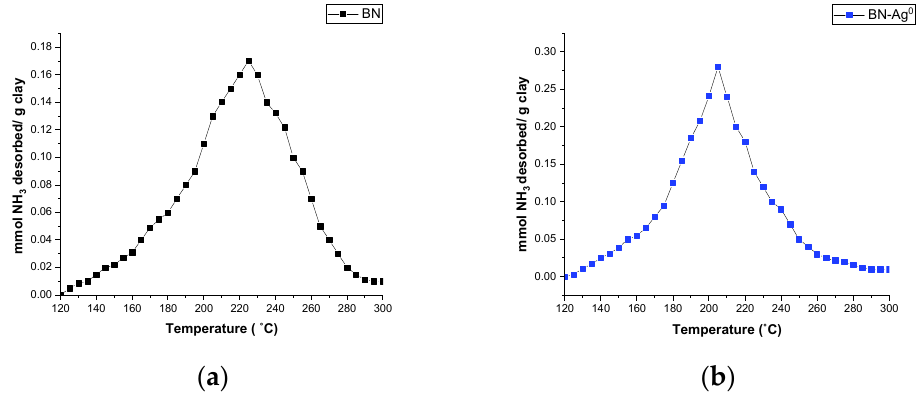
Figure 5. NH 3 TPD diagram of temperature programmed desorption for BN ( a ) and BN-Ag 0 ( b ).